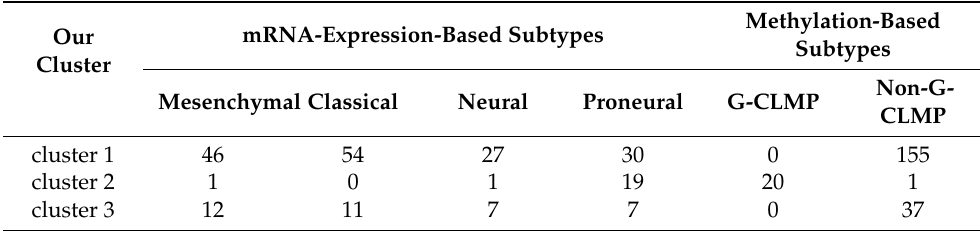
Table 5. The identified clusters are compared with mRNA-expression-based subtypes and methylation-based subtypes.